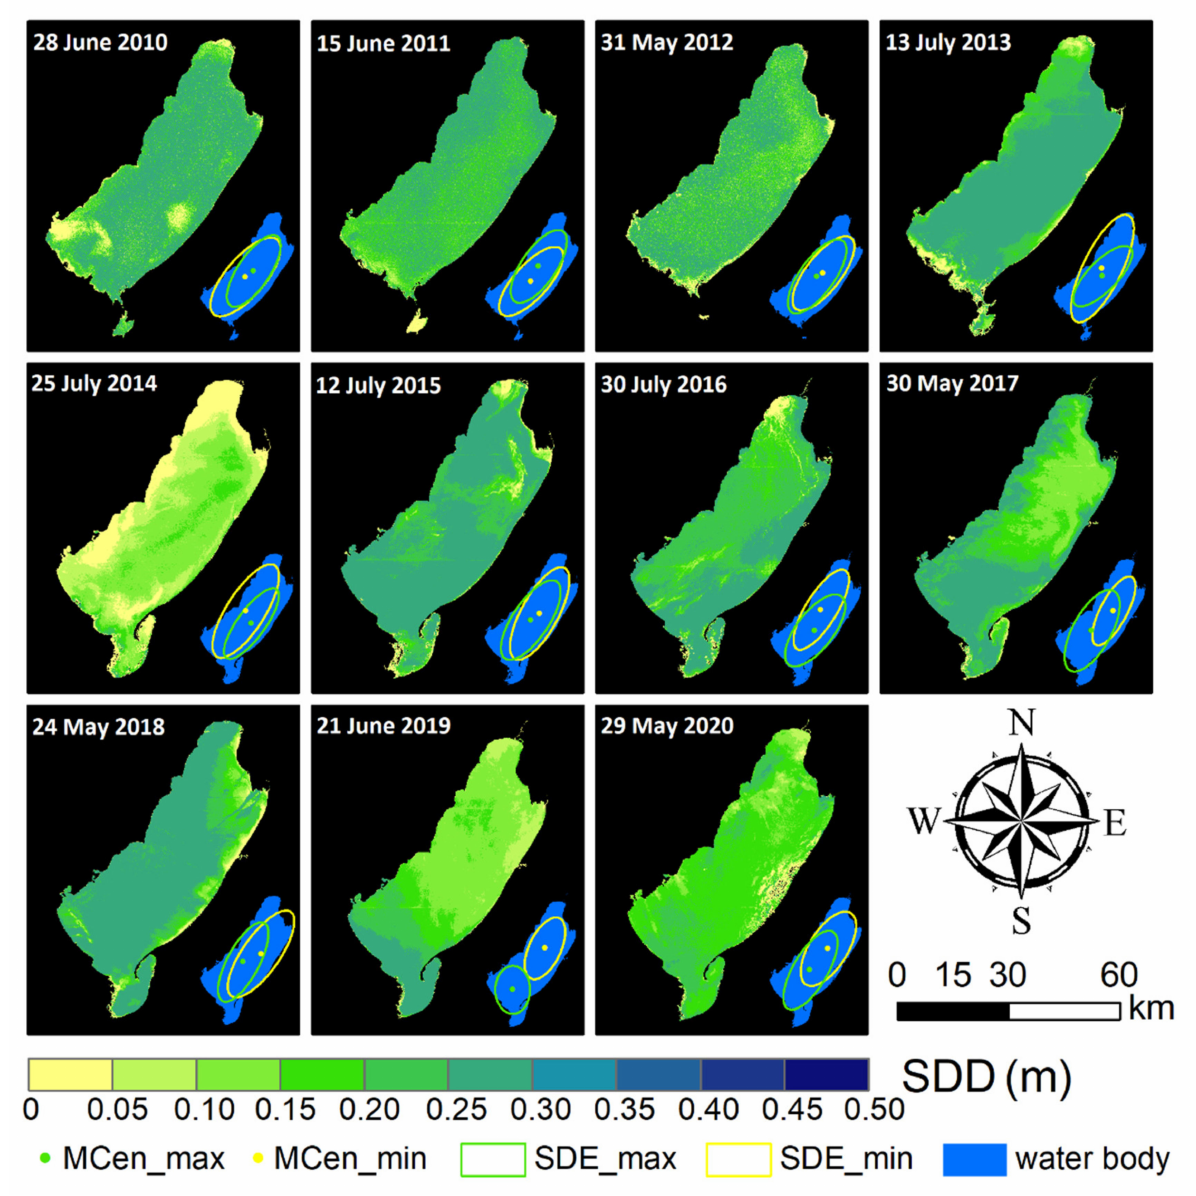
Figure 7. Spatial pattern of summer transparency in Hulun Lake from 2010 to 2020. The lower right corner is the spatial distribution of the standard deviation ellipse and the mean center of the transparency, the blue background represents the current water body range, the green represents the SDD values (>mean), and the yellow represents the SDD values